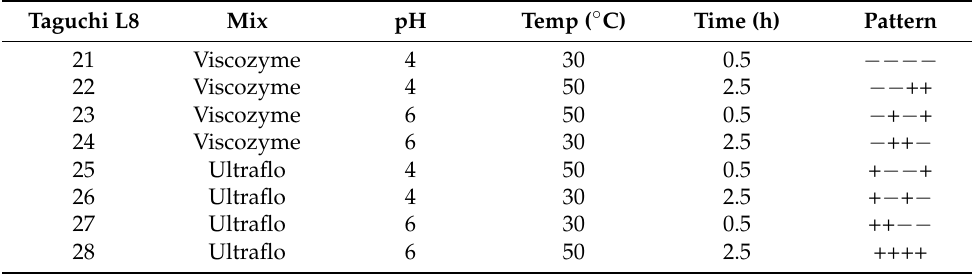
Table A3. Randomly generated Taguchi L8 orthogonal array for the experiment design with four variables and two factors: commercial mix, pH, temperature, and incubation time.